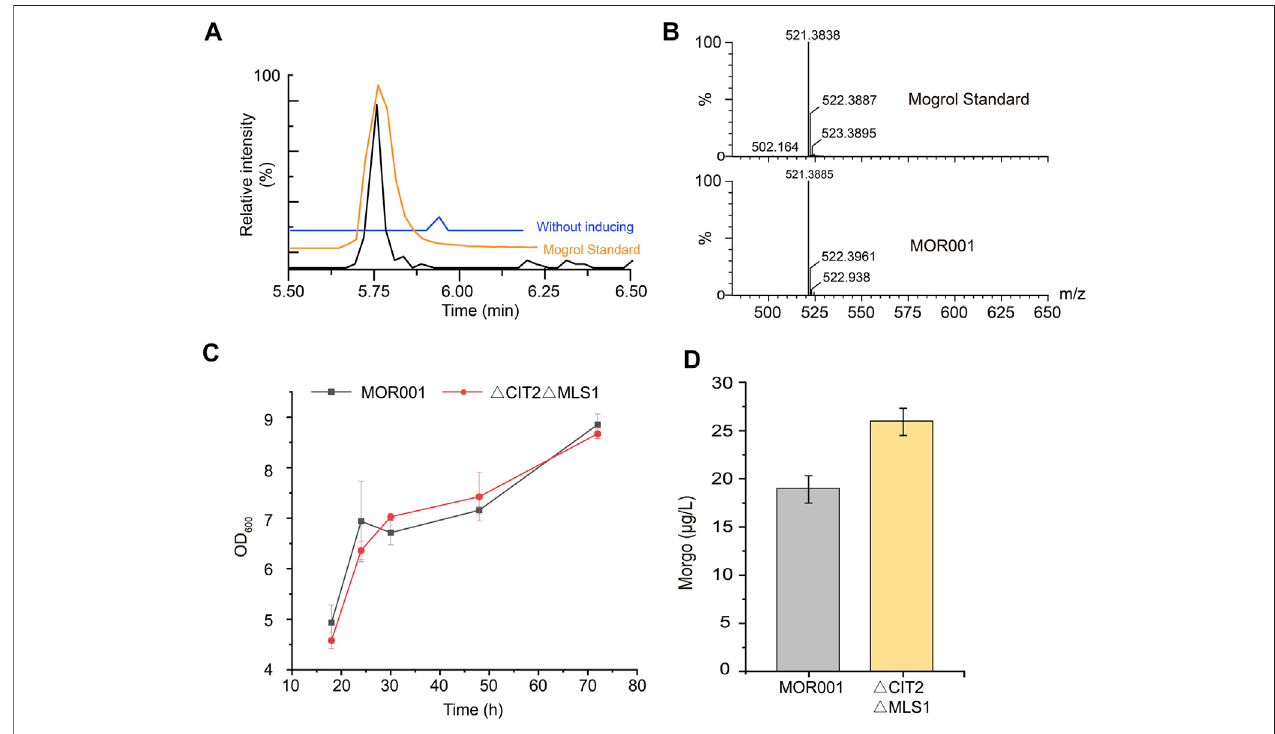
FIGURE 3 | LC – MS analysis of mogrol produced by strain MOR001. (A,B) Chromatogram analysis (A) and mass spectrogram analysis (B) of MOR001 and mogrol standard. The blue line in (A) representsstrainMOR001 inthe YPD medium withoutinduction with galactose (C,D) Cell growth curves (C) and mogrol titer (D) in engineered strain MOR002, in which MLS1 and CIT2 genes were knocked out. Error bars represent the SD of biological triplicates ( n =